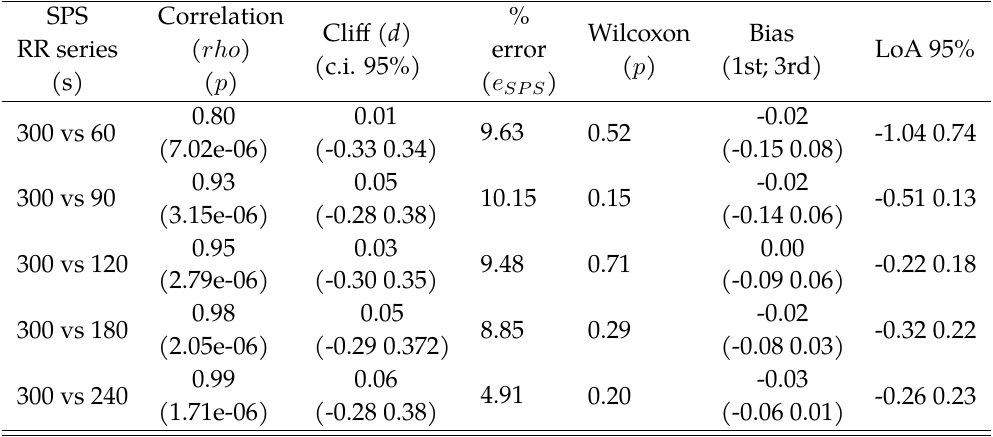
Table 5: Analysis of concordance between GS and different time series of the SPS